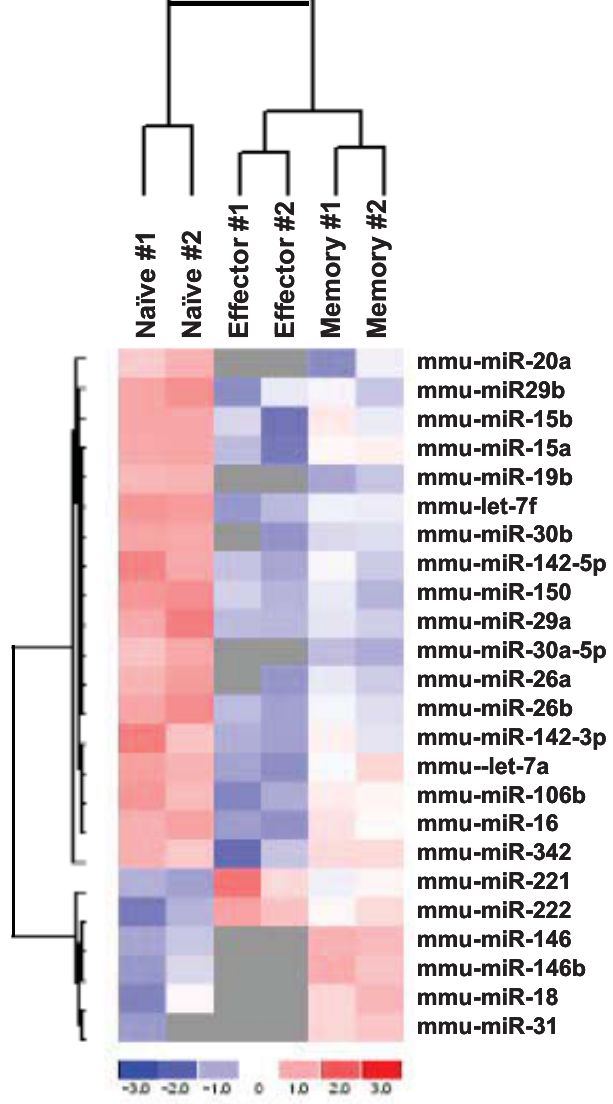
Figure 2. Differential expression of miRNAs in naı¨ve, effector and memory T cells. Signal intensity for a particular miRNA in each cell type was divided by that of the pooled RNA reference sample to generate the heat map. Same amount of total RNA is used for each slide (so the signal is actually normalized according to total RNA). The miRNA clustering tree is shown on the left and the sample clustering tree is shown on the top. The color scale shown at the bottom illustrates the relative expression level of the indicated miRNA across all samples: red denotes an expression above the mean, blue denotes an expression lower than the mean and grey represents signal lower than the background.